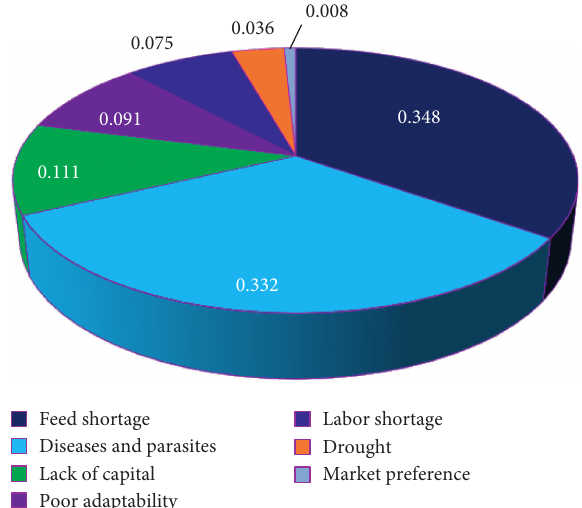
Figure 2: Major constraints to goat crossbreeding (the pie chart is based on weighted